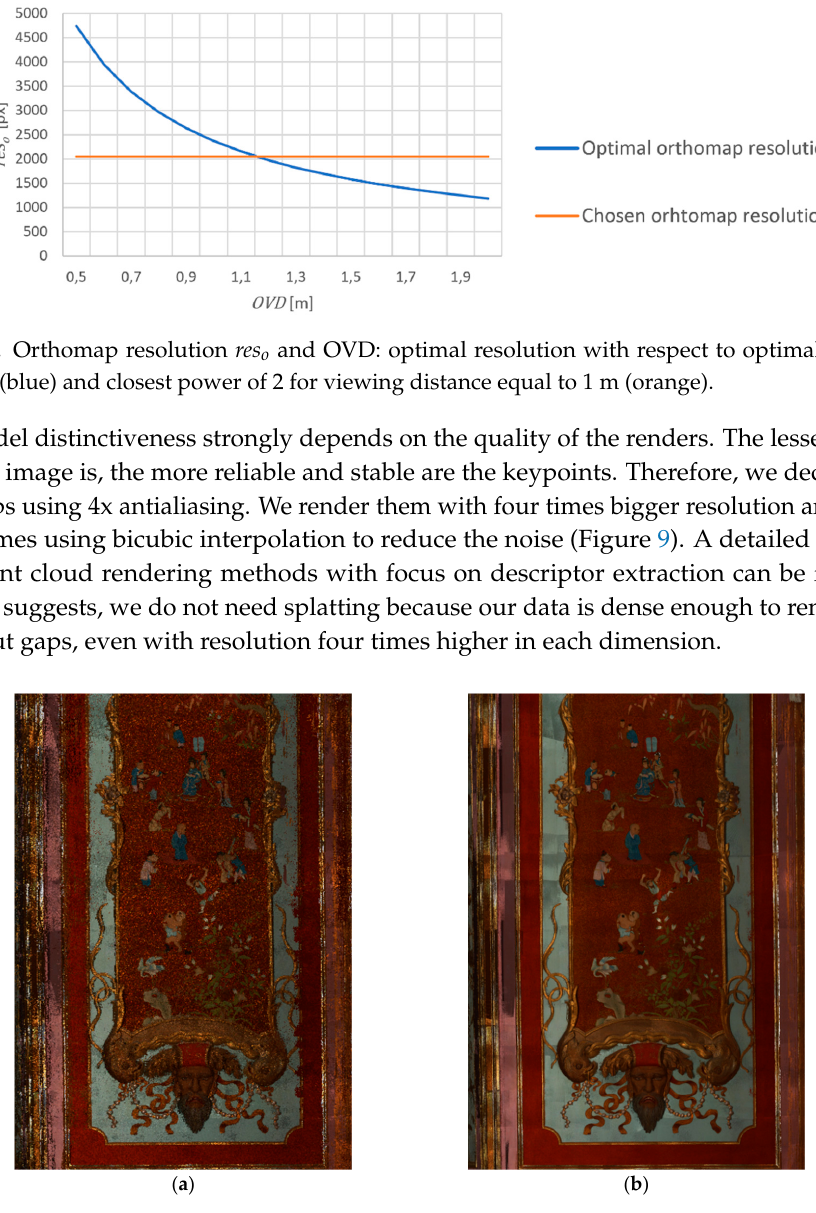
Figure 9. Comparison between orthomaps rendered in different resolutions: ( a ) native resolution and ( b ) with four times of antialiasing.